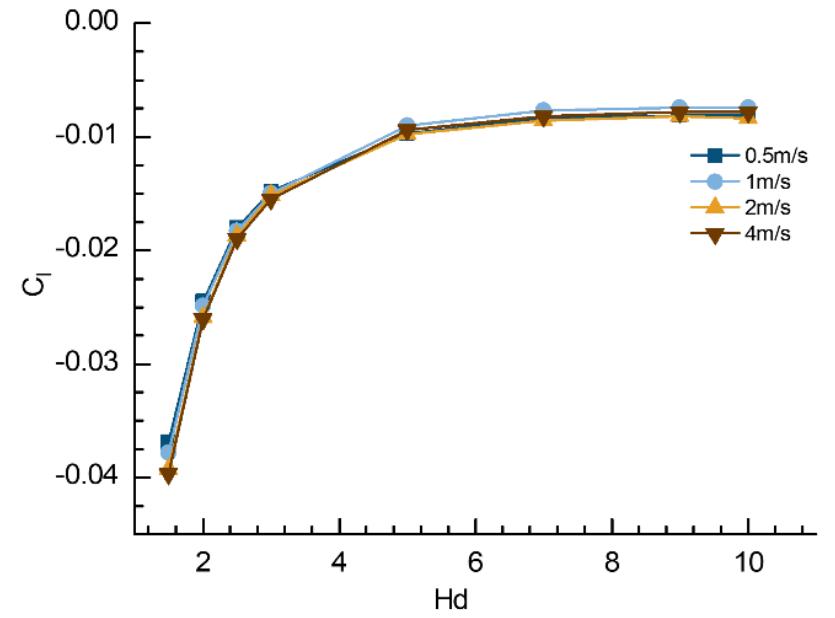
Figure 12. Self − propelled UUV lift characteristics. Similar to the bare UUV, the self-propelled UUV takes the buoyancy center of the UUV with a propeller as the origin of the pitching moment. The pitch moment coefficient of the self-propelled UUV decreases with the increase of Hd and finally tends to be around 0.005, and the variation rate of the coefficient is the largest near the seabed. As can be seen from Figure 13, the pitching moment coefficient near the seabed is larger than that away from the seabed, which causes the dive phenomenon near the seabed without angle of attack. The pitching moment curve of the self-propelled UUV varies with Hd and Re L according to the same trend as that of the bare UUV. However, the pitching moment coefficient of the self-propelled UUV increased by 100~300% relative to that of the bare UUV when the Hd less than